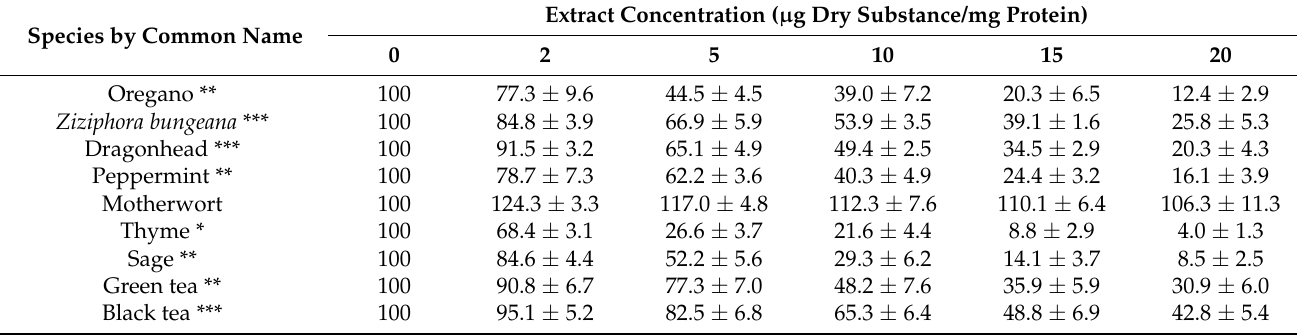
Table 3. Effect of herb extracts of family Lamiaceae on the level of lipid peroxidation in the liver microsome. Note: mean ± SD, n = 3. Species by Common